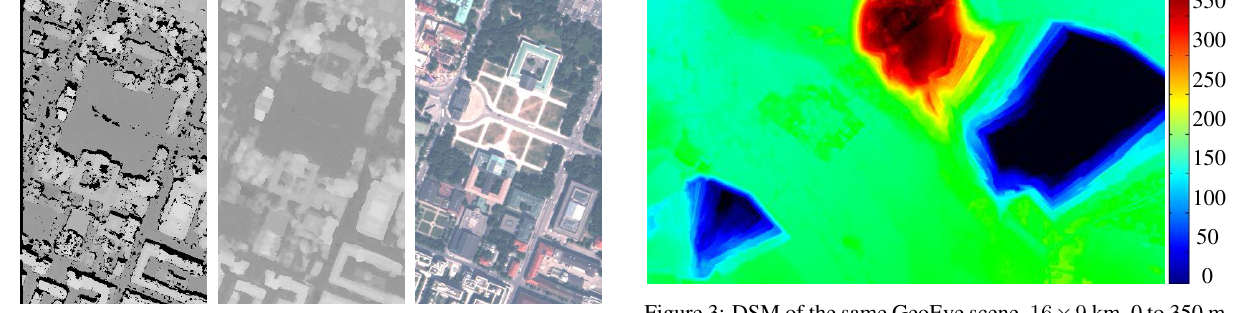
Figure 1: Height map fitting on first pan image, corrected height map, pan-sharpened first image (l.t.r.), example from a WorldView-2 scene of Munich, K¨onigsplatz, 300 m × 500 m each